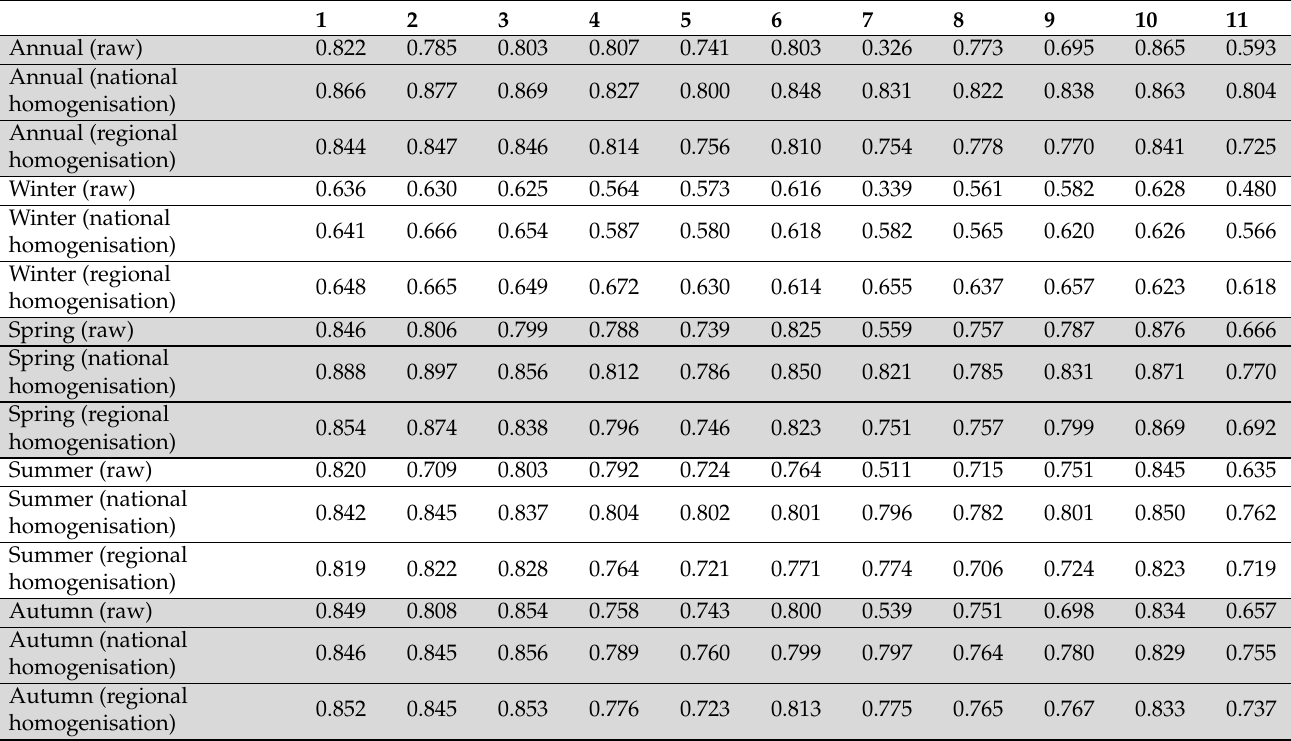
Table A12. Pearson correlations between the Central England series [41] and the raw and homogenised MIN series in 1885–2018. All correlations are significant at the 0.01 level. Series: (1) Phoenix Park Dublin, (2) Botanic Gardens,